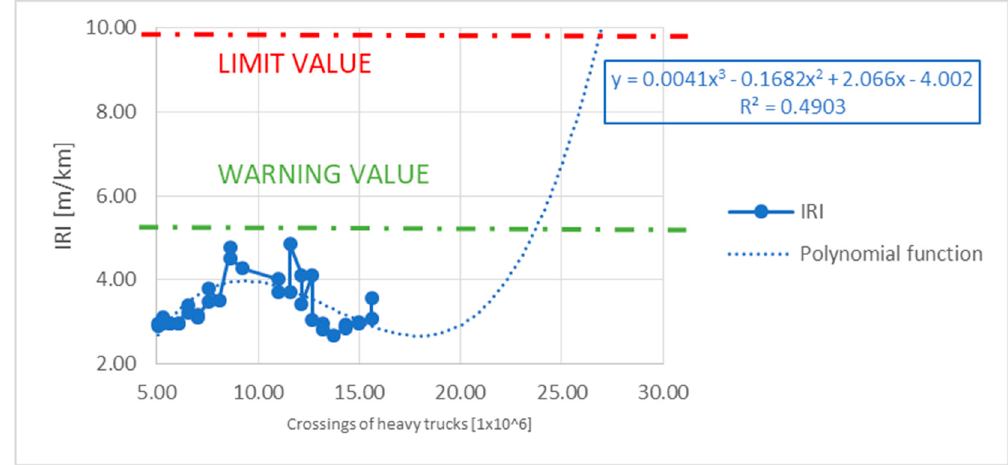
Figure 9. IRI and its probable course.